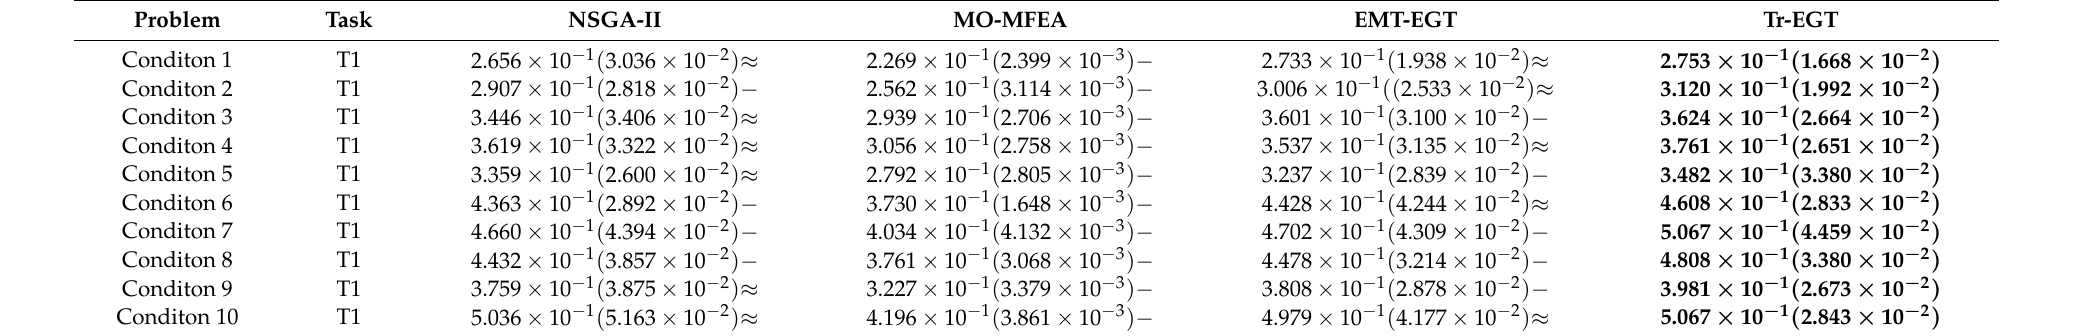
Table 6. Averaged HV value and Standard Deviation obtained by NSGA-II, MO-MFEA, EMT-EGT, and Tr-EGT of task 1 on ten conditions.